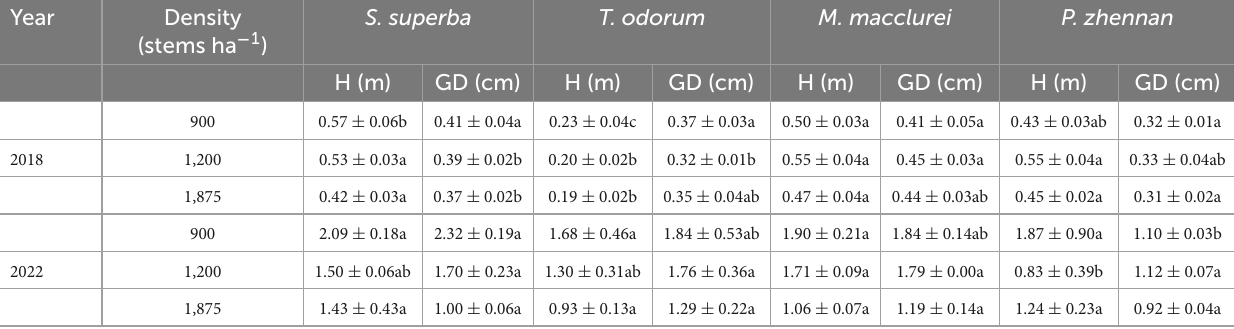
TABLE 2 Average tree height (H), diameter at breast height (DBH), and ground diameter (GD) of seedlings of broad-leaved trees planted under different stocking density of Chinese